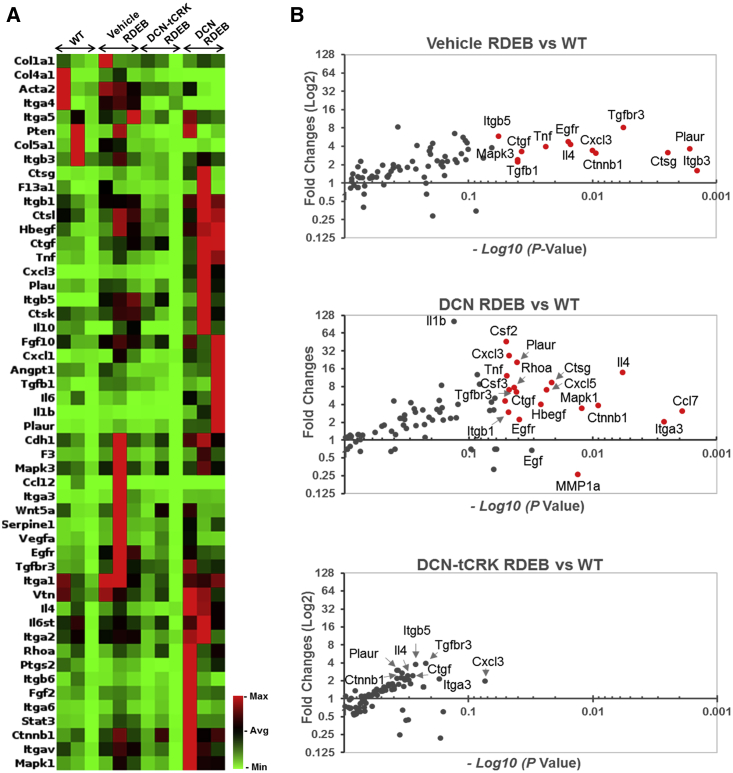
DCN-tCRK Normalizes Fibrotic Gene Signature in RDEB(A) Relative gene expression in clustergram for the genes that had a >1.5-fold increase in expression in the untreated RDEB skin than for the WT. (B) Volcano plots on log2 fold changes and −log10 p values of gene expression in the vehicle-, DCN-, and DCN-tCRK-treated col7a1−/− mouse skin relative to the WT.